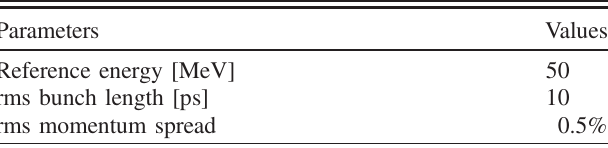
TABLE II. The initial parameters of the injected beam in the longitudinal phase